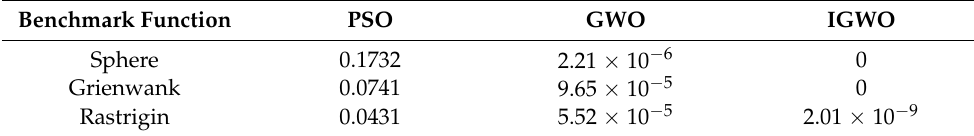
Table 4. Average results of convergence accuracy of different